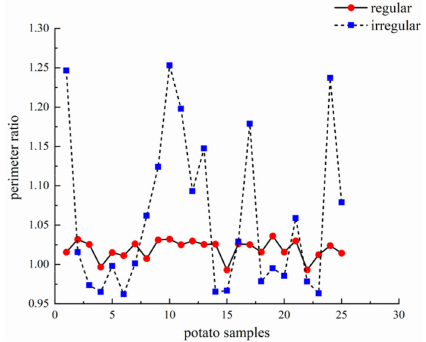
Figure 8. Perimeter ratio of potatoes.